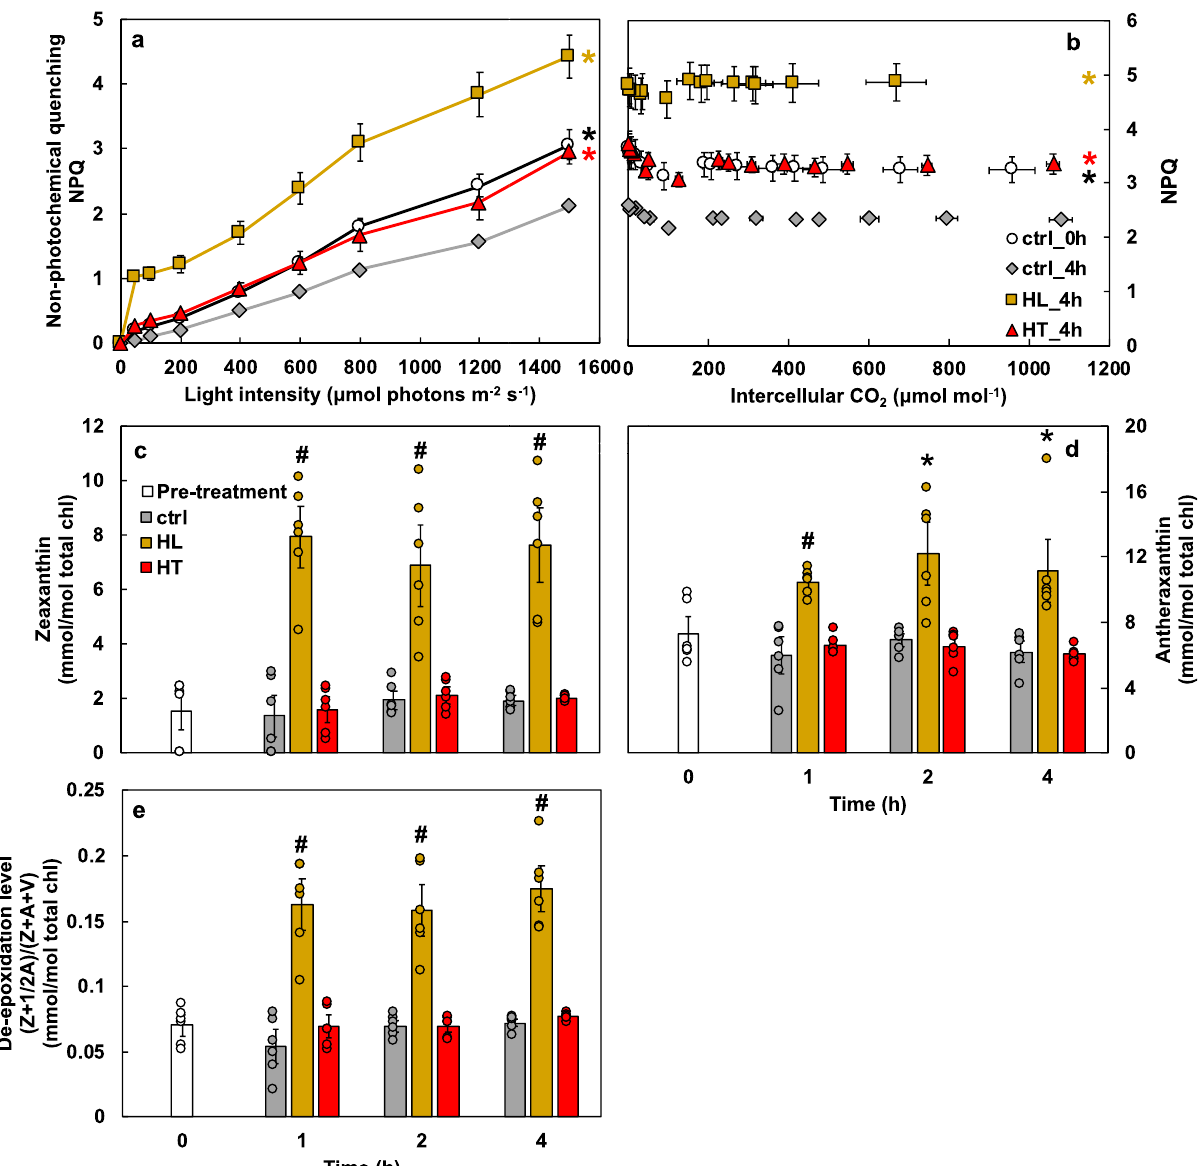
Fig. 6 High light induced non-photochemical quenching (NPQ) and increased zeaxanthin as well as de-epoxidation levels. a Light and b CO 2 response of NPQ. Mean ± SE, n = 3 – 6 biological replicates. Most data points of ctrl_0h, HL_4h, and HT_4h were statistically signi fi cantly different compared to ctrl_4h using Student ’ s two-tailed t -test with unequal variance, denoted by asterisks at the end of curves. p -Values were corrected for multiple comparisons using FDR ( * p < 0.05, the colors of * match the signi fi cance of the indicated conditions, black for ctrl_0h, yellow for HL_4h, red for HT_4h). c – e Concentrations of zeaxanthin, antheraxanthin, and xanthophyll cycle de-epoxidation. Mean ± SE, n = 3 biological replicates. Asterisk and pound symbols indicate statistically signi fi cant differences of high light or high temperature treatments compared to the control condition at the same time points using Student ’ s two-tailed t -test with unequal variance ( * 0.01 < p < 0.05, # p <